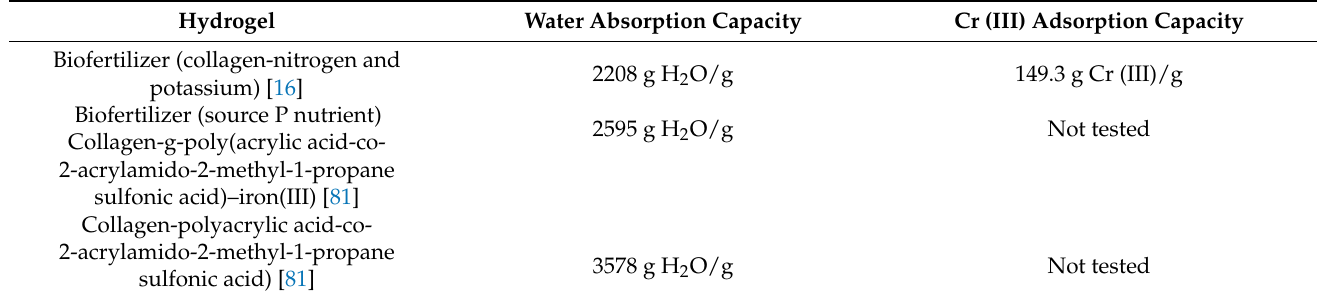
Table 1. Comparison among different types of biopolymer-based